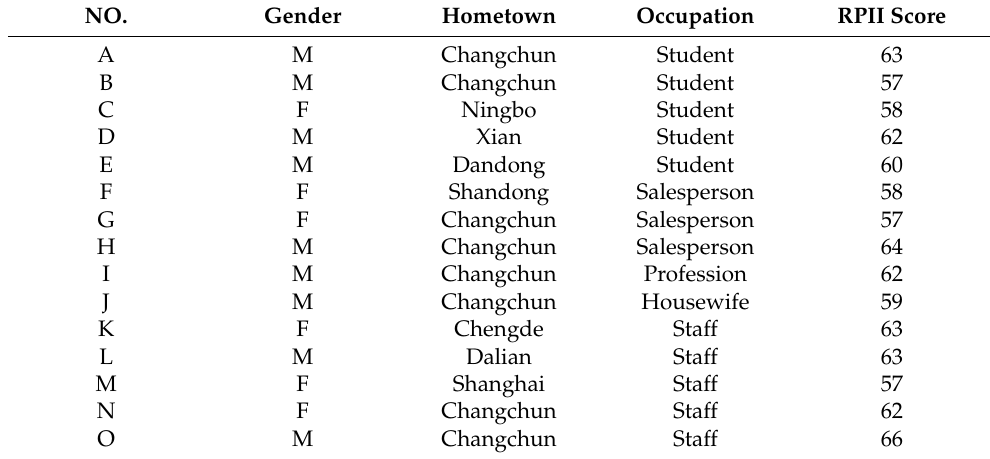
Table 1. Data per the revised personal involvement inventory